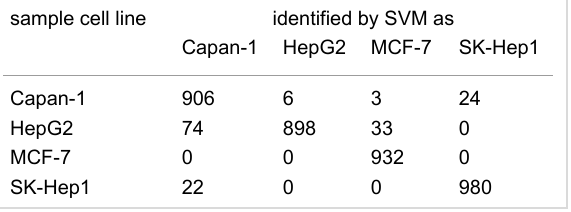
Table 1: Results of the identification of different cell lines. The support vector machine model (SVM) model was trained with spectra taken from three different batches of each cell line and tested with data taken from the remaining three batches. The SVM model was run for 20 dif- ferent